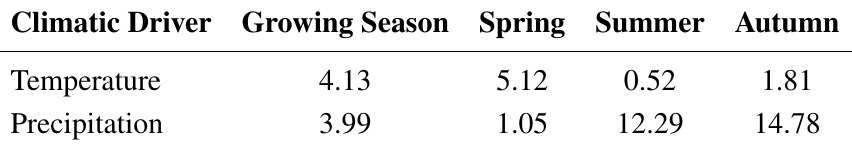
Table 3. Percentage of area showing significant lag effects of temperature and precipitation on the average NDVI of growing season, spring, summer and autumn